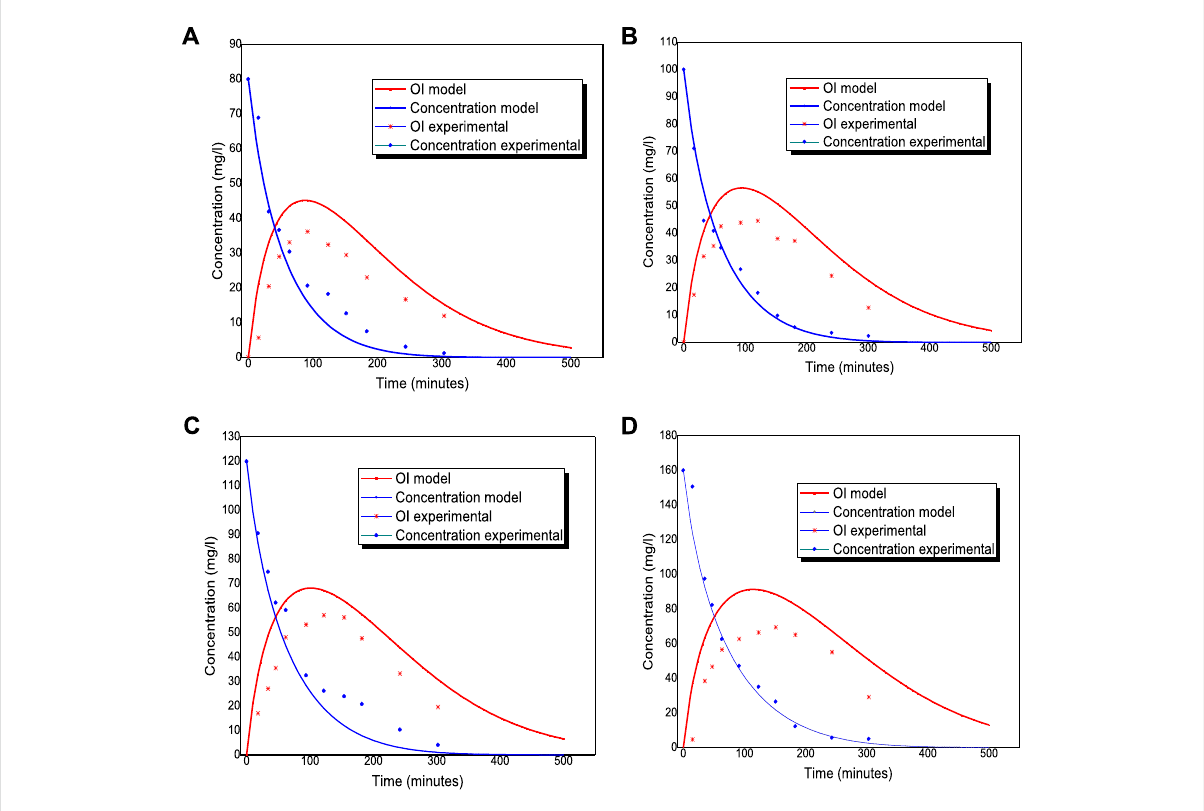
FIGURE 4 Resultoftheapplication oftheLH-HWmodelpredicting thedecomposition ofacetaminophenandtheformation andconsumptionoforganic intermediates,thecontinuouslinesrepresentthemodelestimatesandthepointsoftheexperimentaldata. (A) C ACET =80 mg/l, (B) C ACET =100 mg/l, (C) C ACET = 120 mg/l, and (D) C ACET = 160